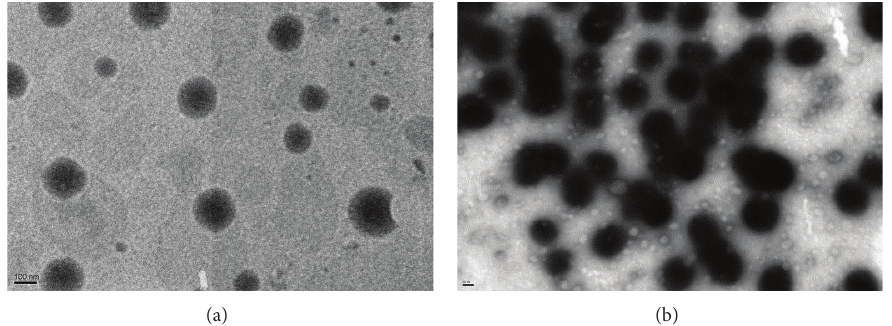
Figure 3: TEM photographs for NLC(A) and NLC + 2% HP 𝛽 CD (100000x). Scale bar in (a) and (b) represents 100 and 50 nm, respectively. The size of the NLCs was 190 and 360 nm, respectively.